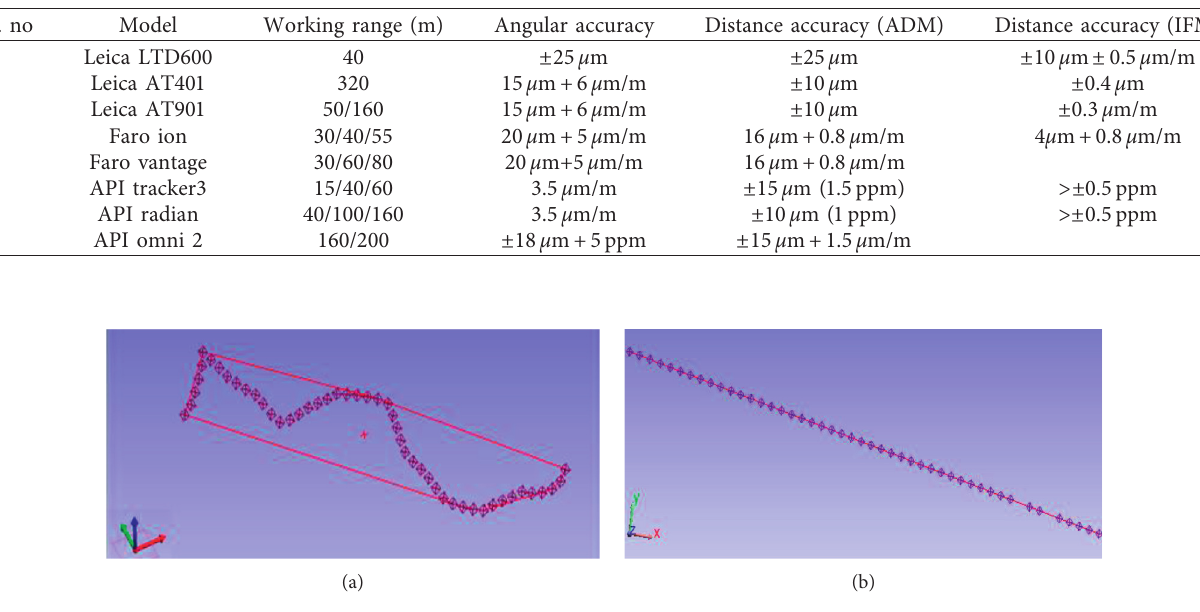
Figure 5: Points measured on surface plate. (a) Measured on surface. (b) Measured on edge.